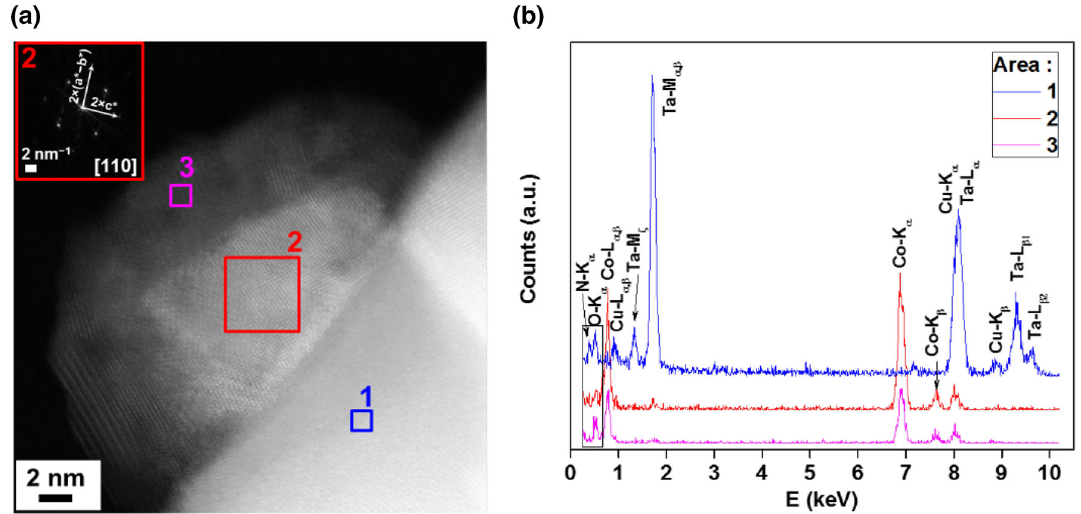
b X-ray fluorescence spectra of Ta 3 N 5 ( 1 ), the core ( 2 ) and the shell ( 3 ) of an agglomerate as depicted on ( a ). Figures adapted with permission from [99] Copyright (2015) American Chemical Society